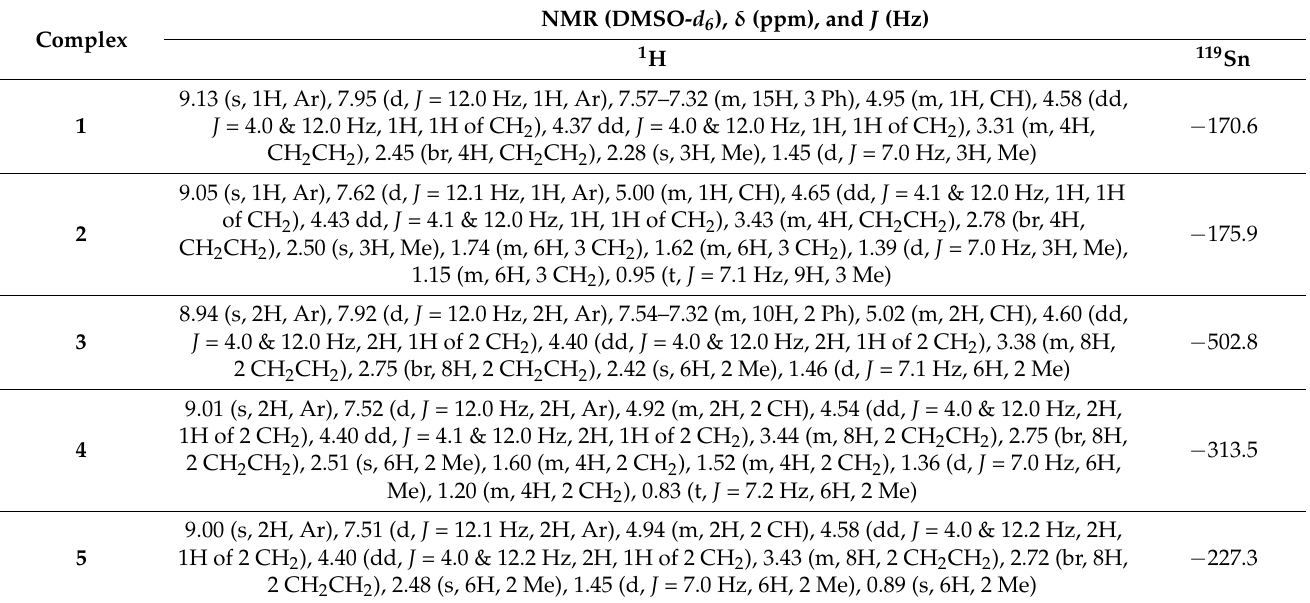
Table 3. 1 H and 119 Sn NMR spectral data for 1 – 5